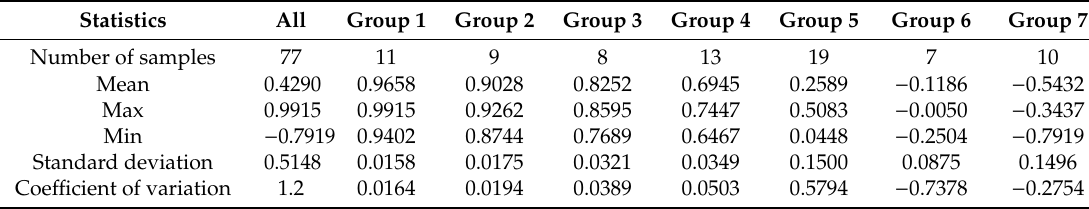
Table 4. Descriptive statistics of correlation results.